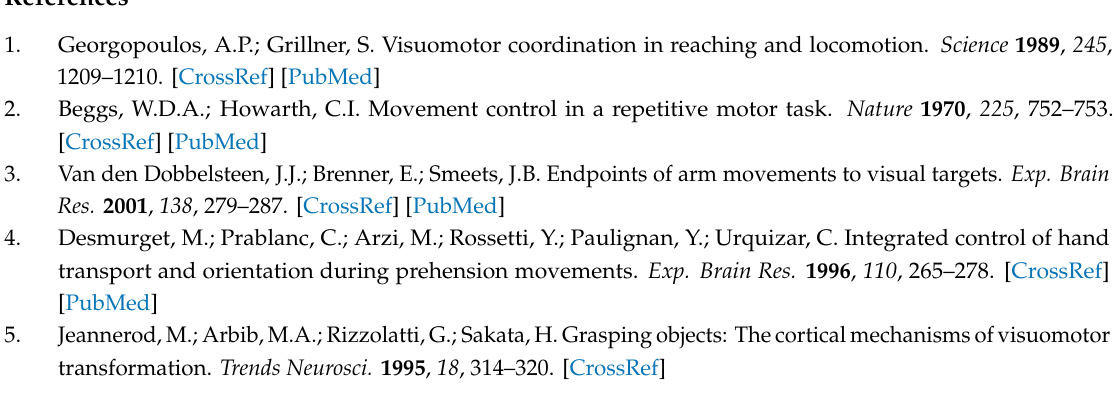
Table S1: A summary of statistical analysis of ∆ R for the circular tracking movement; Table S2: A summary of statistical analysis of ∆ θ for the circular tracking movement; Table S3: A summary of statistical analysis of ∆ ω for the circular tracking